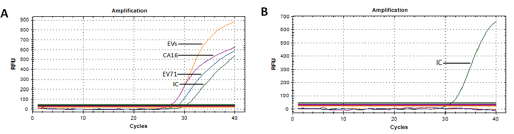
Figure 1. The results from triplex RT-PCR. A. Detection of mixed samples of EV71 and CA16 in one tube. B. Detection of the negative control.